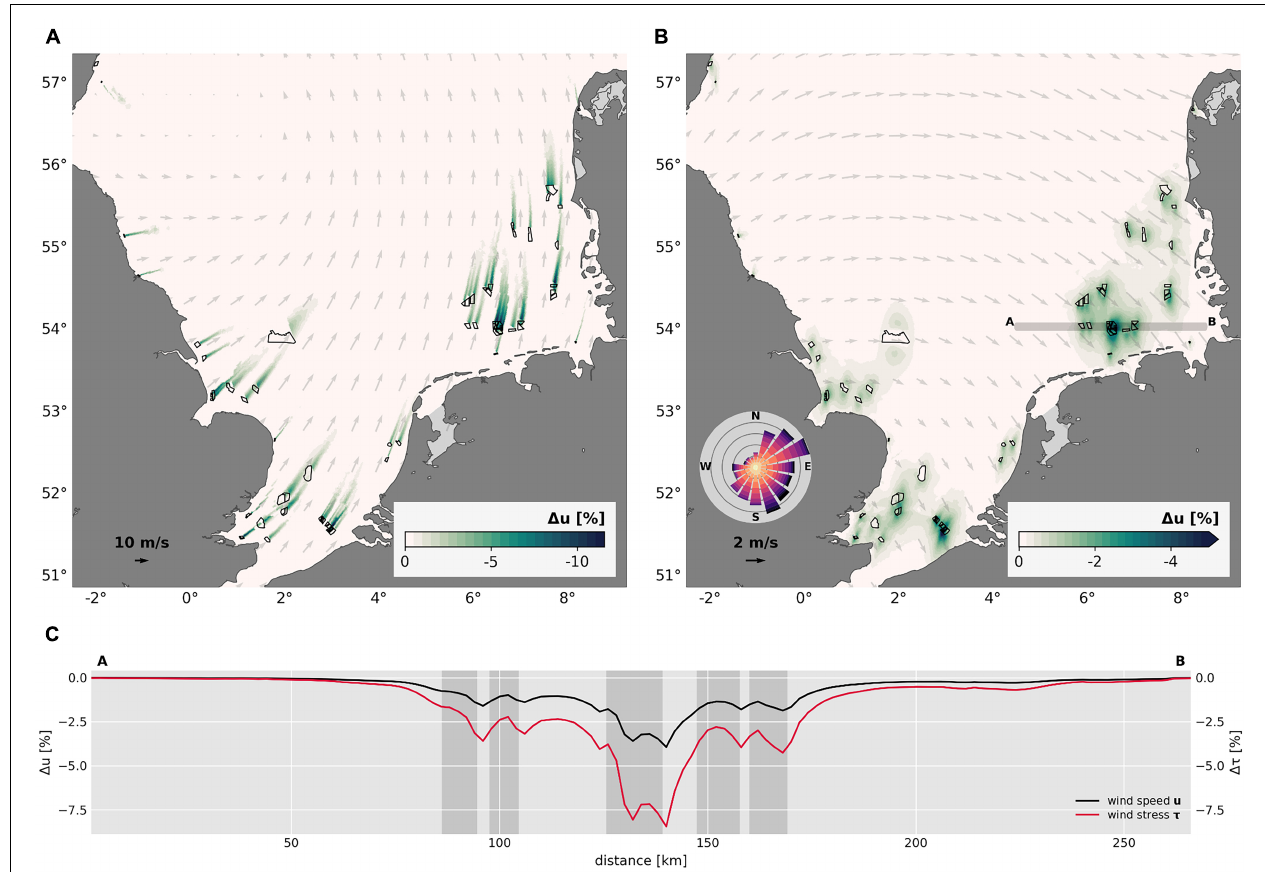
FIGURE 5 | Relative changes in mean wind speed ( u ): Instantaneous changes for a strong wind event on 10 May 2013 (A) and mean wind speed changes for the period of May – September 2013 (B) . Gray arrows indicate mean wind direction. The wind rose indicates the direction in which the wind blew (color range between 1 and 12 m/s). (C) Relative changes in wind speed ( u ) and wind stress ( τ ) along transect (A,B) . Gray areas indicate locations of offshore wind